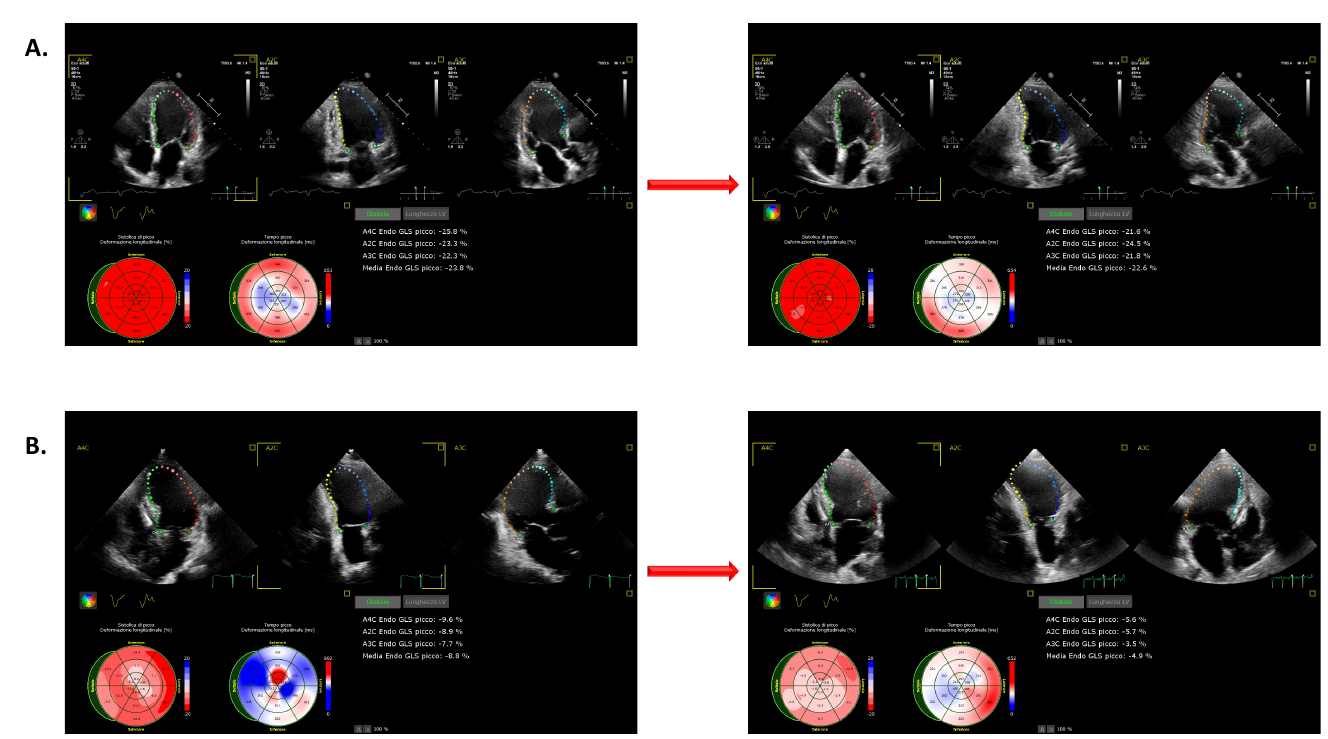
Figure 2. Two examples of changes in LVGLS. The example in ( A ) documents improved LVGLS with increasing HR. The example in ( B ) documents a deterioration in LVGLS in response to increasing